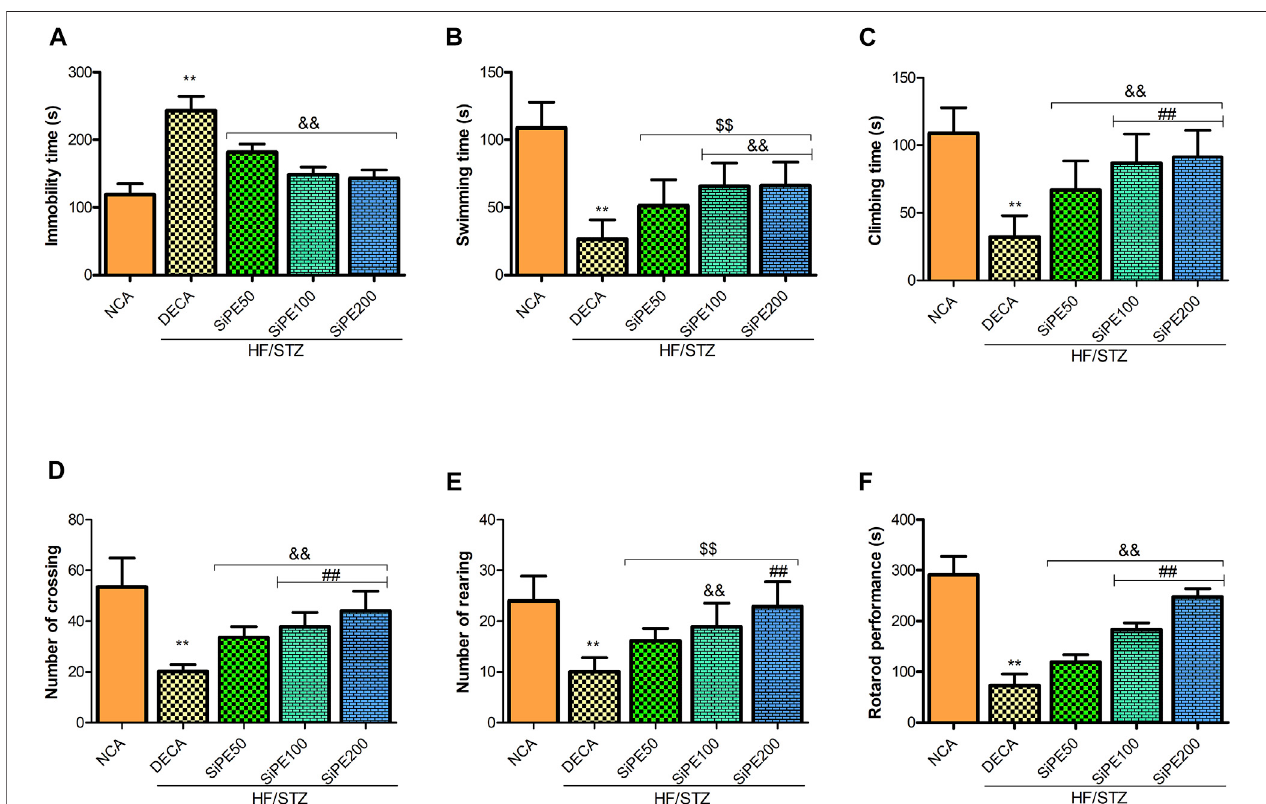
FIGURE 4 | Effect of SiPE treatment on depressive-like behaviours and motor coordination in HF/STZ-induced diabetic encephalopathic rats. SiPE treatment at dose of 50, 100 or 200 mg/kg signi fi cantly ameliorated (A) immobility time, (B) swimming time, (C) climbing time, (D) number of crossing, (E) number of rearing and (F) rotarod performance compared to DECA group. Data are presented as mean ± SD ( n (cid:2) 5 – 6) and one-way ANOVA test was applied. ** p < 0.001 indicates statistical signi fi cance compared to NCA group. ## p < 0.001, && p < 0.01 and $$ p < 0.05 indicate statistical signi fi cance compared to DECA group.